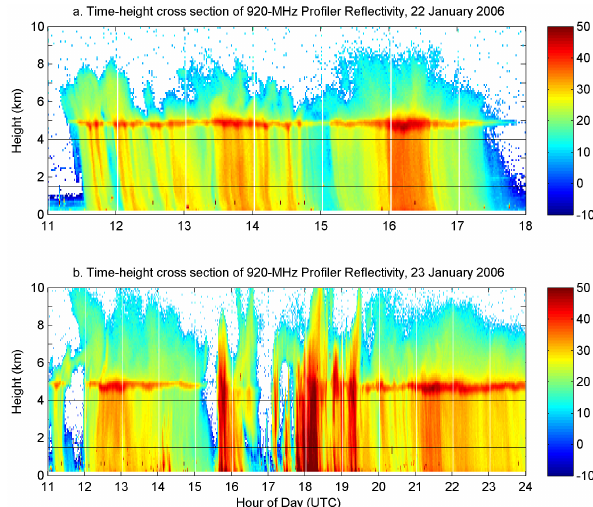
Fig. 3. Time-height cross section of radar reflectivity from the ver- tically pointing 920-MHz profiler for (a) 22 January and (b) 23 Jan- uary 2006 during TWPICE. The lines at 1.5 and 4.0km indicate the altitude range of DSD retrievals used in this